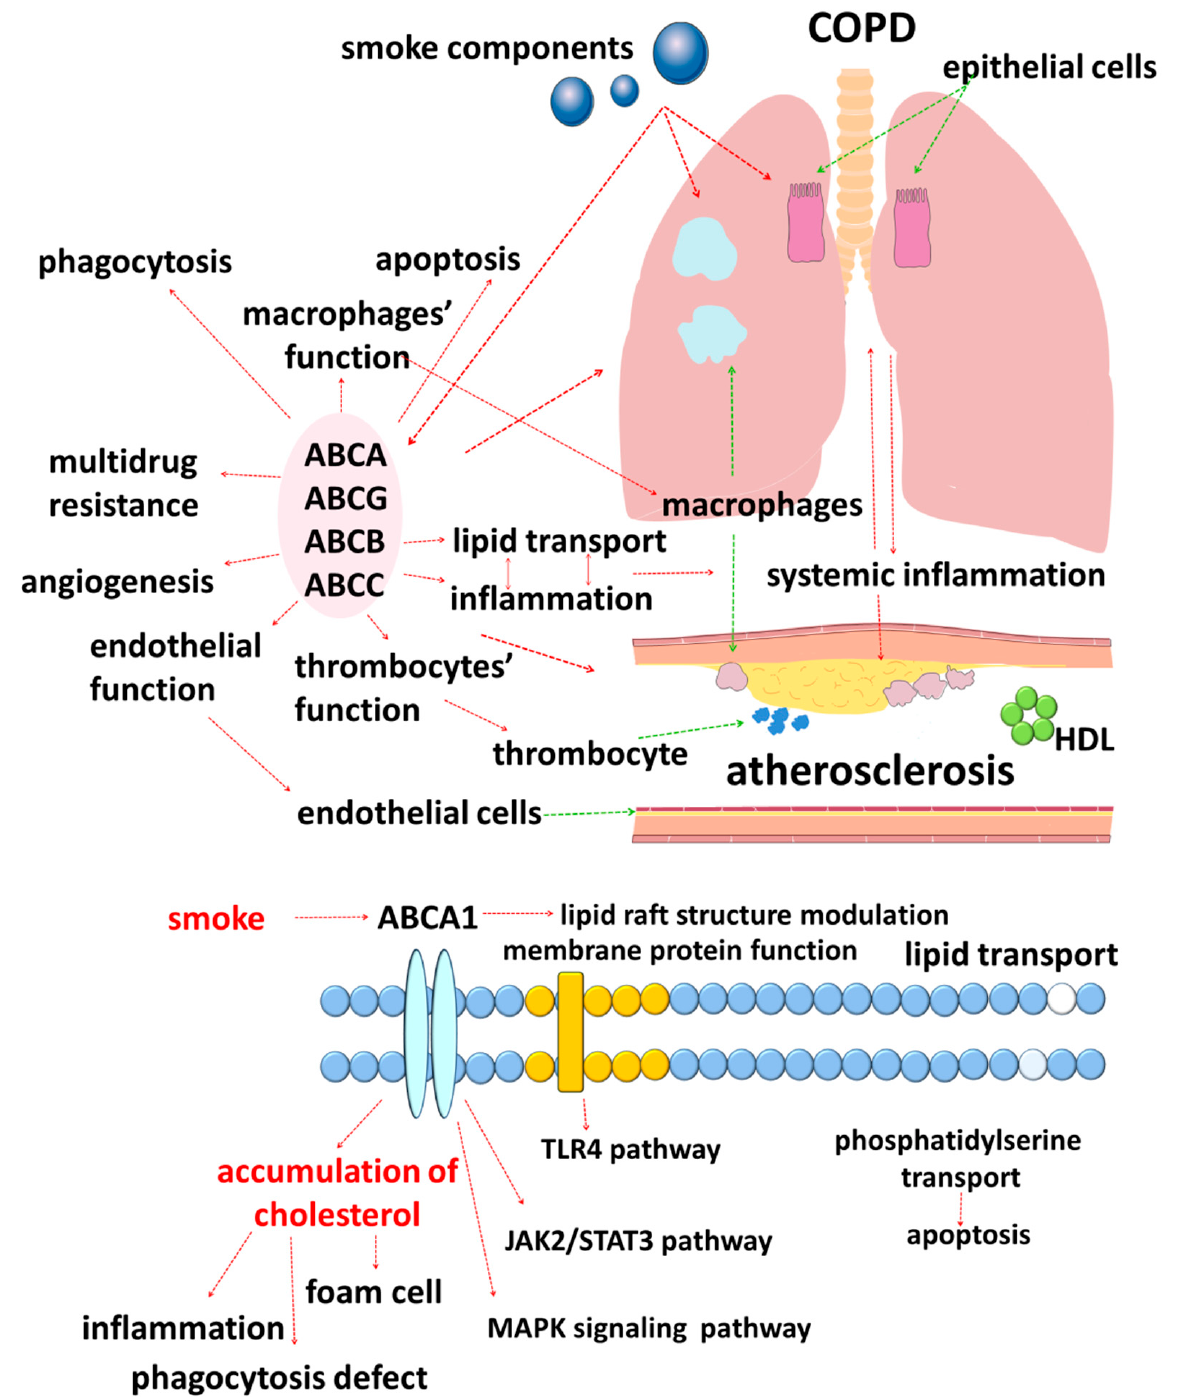
Figure 1. Schematic image of the involvement of ABC transporters in the pathogenesis of COPD and atherosclerosis. ABC transporters are a large family of membrane proteins that transport chemically diverse substrates through the lipid bilayer of cell plasma membranes while accompa- nied by ATP hydrolysis [47,48]. Currently, 49 different genes encoding ABC transporters are known in humans, which, based on the structural features, are divided into seven subfamilies, designated ABCA–ABCG